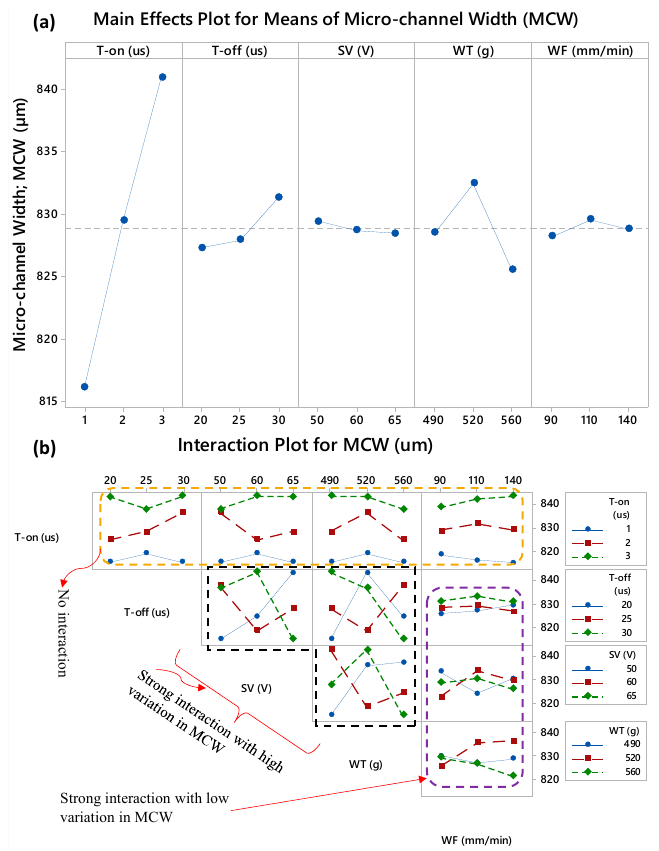
Figure 9. Parametric effects on micro-channel’s width (MCW): ( a ) main effects plot and ( b ) interaction plot.